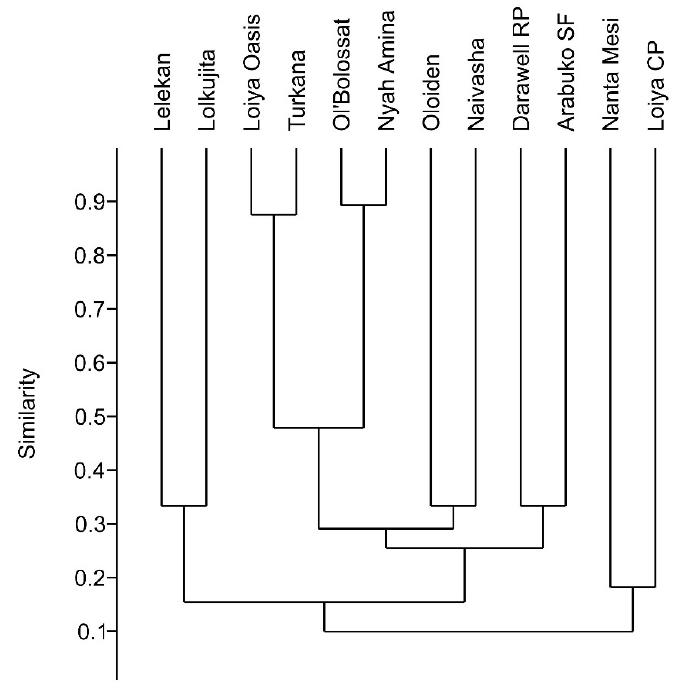
Figure 4. Hierarchical cluster analysis based on unpaired group (UPGMA) Jaccard similarity index.